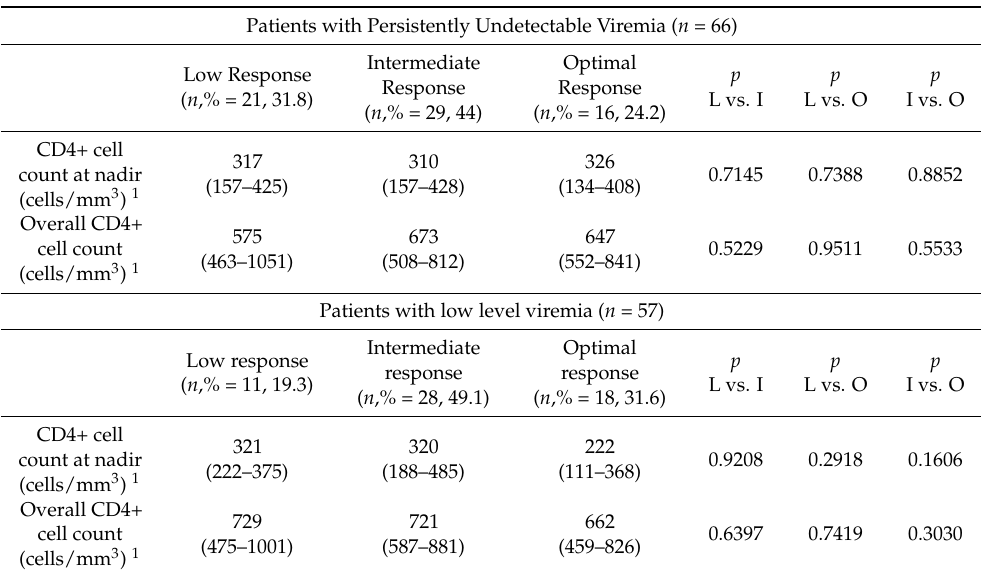
Table 2. Absolute number of CD4+ cell count at nadir and as overall CD4+ cells value according to IgG response at T2 and plasma HIV RNA